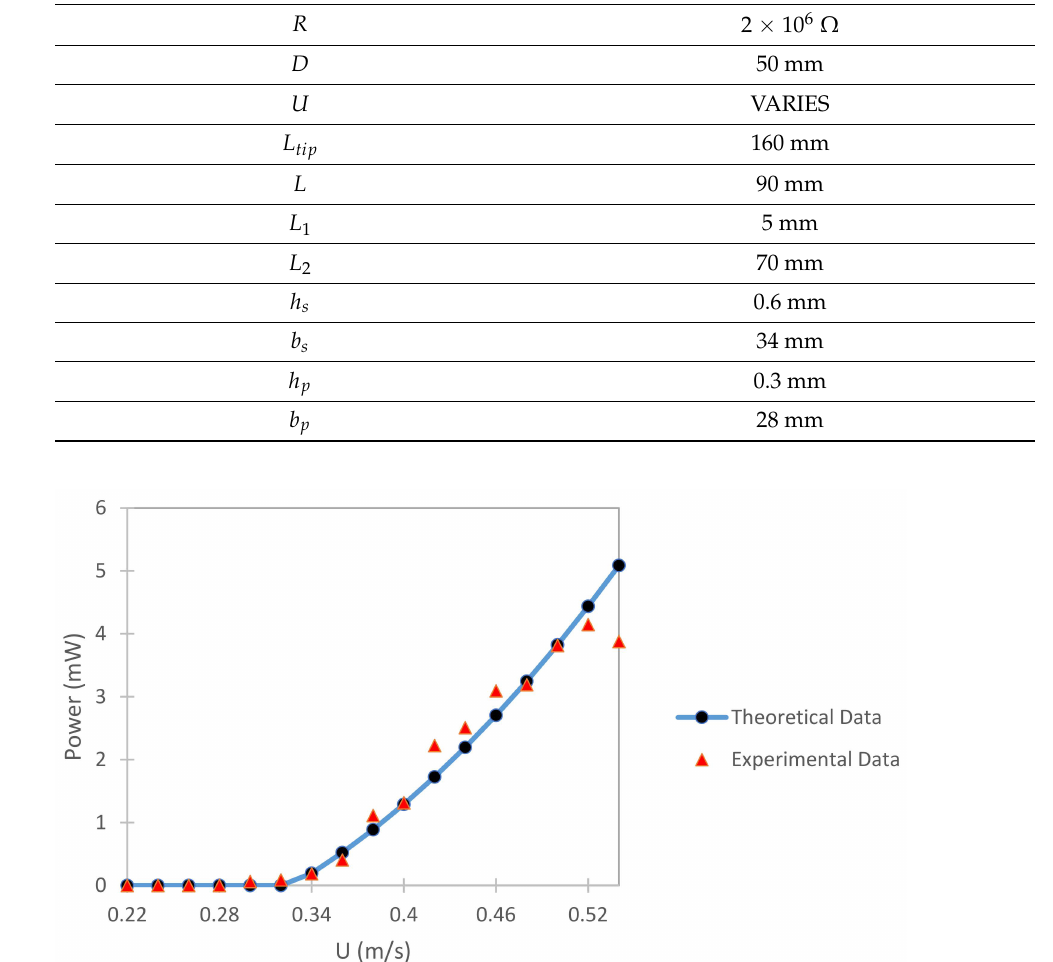
Figure 2. Graph Showing Experimental and Theoretical Values of Harvested Power Varied with Water Velocity U